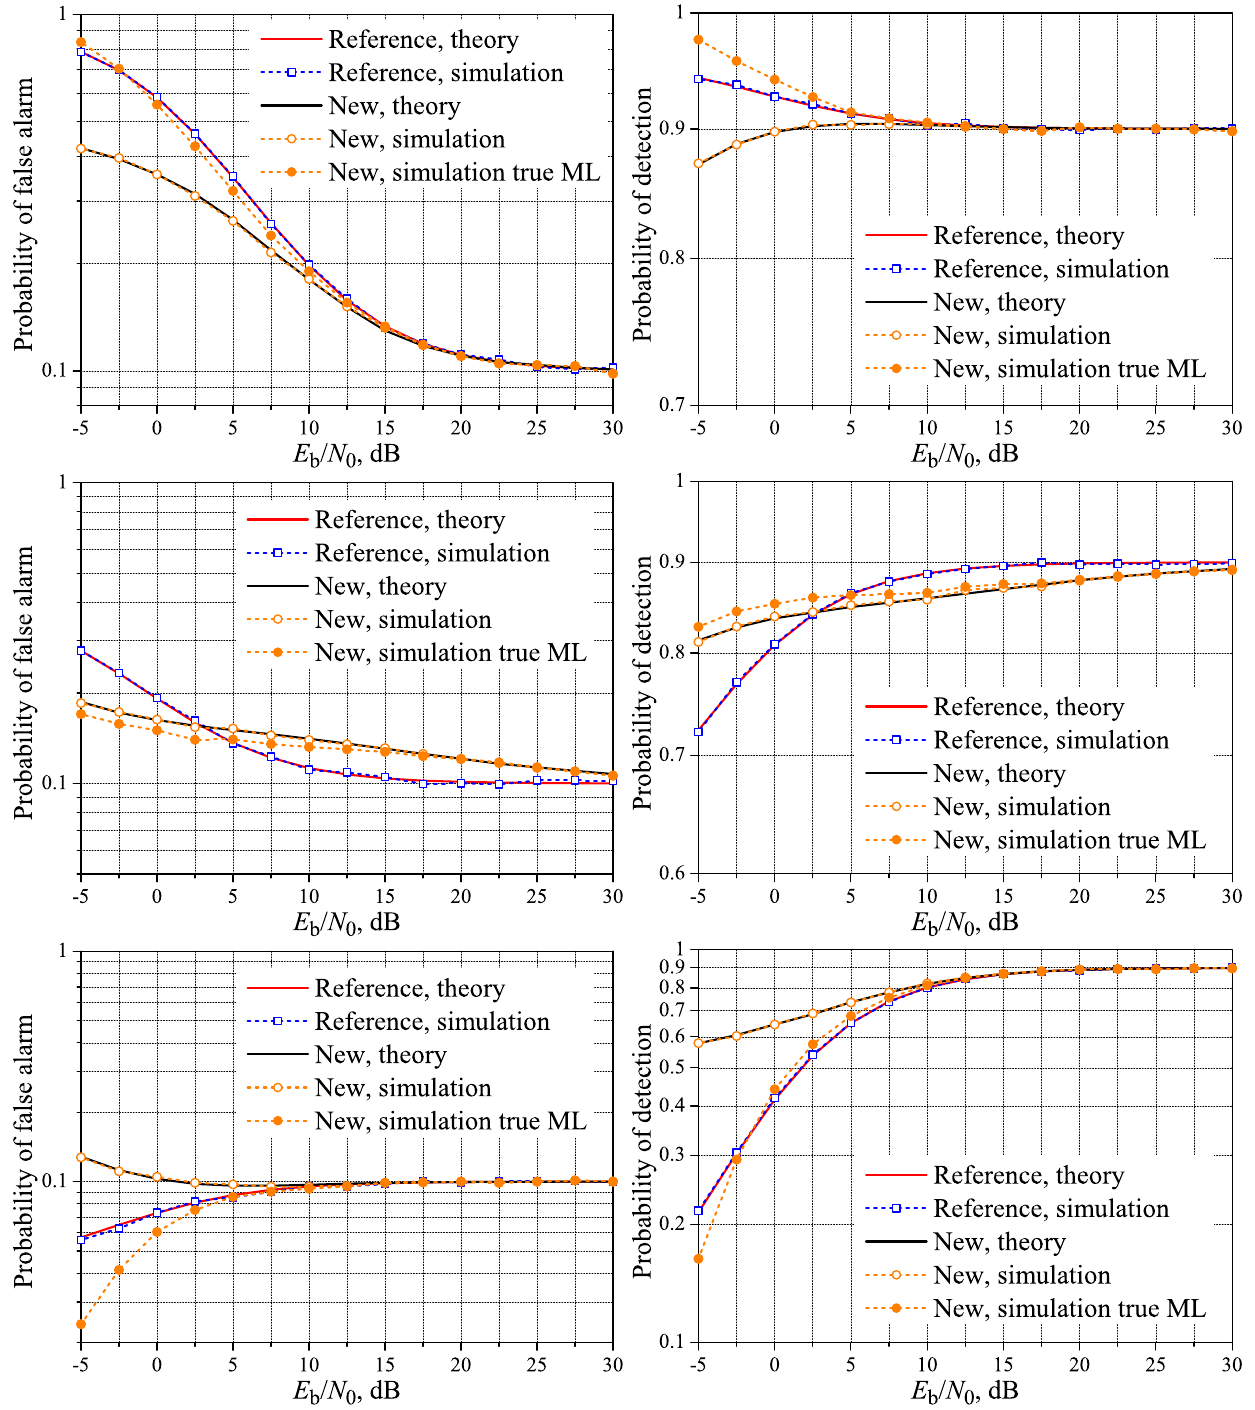
Figure 5. Spectrum sensing performance for the real-valued Rayleigh reporting channel. M = 5 and K = 1 ( top ); K = 3 ( middle ); and K = 5 ( bottom